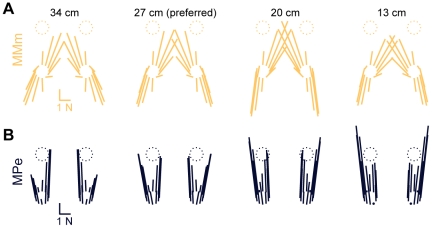
Predicted horizontal plane forces obtained by altering the cost function and the task level variable.
A: model MMm predictions (yellow). Note that unlike MMe predictions (Figure 4A), MMm predictions are approximately constant as stance distance decreases. Compare changes between 34 cm and 13 cm to changes in Figure 4A. B: model MPe predictions (blue). Note that predicted forces are near the anterior-posterior axis, the strongest axis of force production in the isolated hindlimb [20] in all perturbation directions and postural configurations.